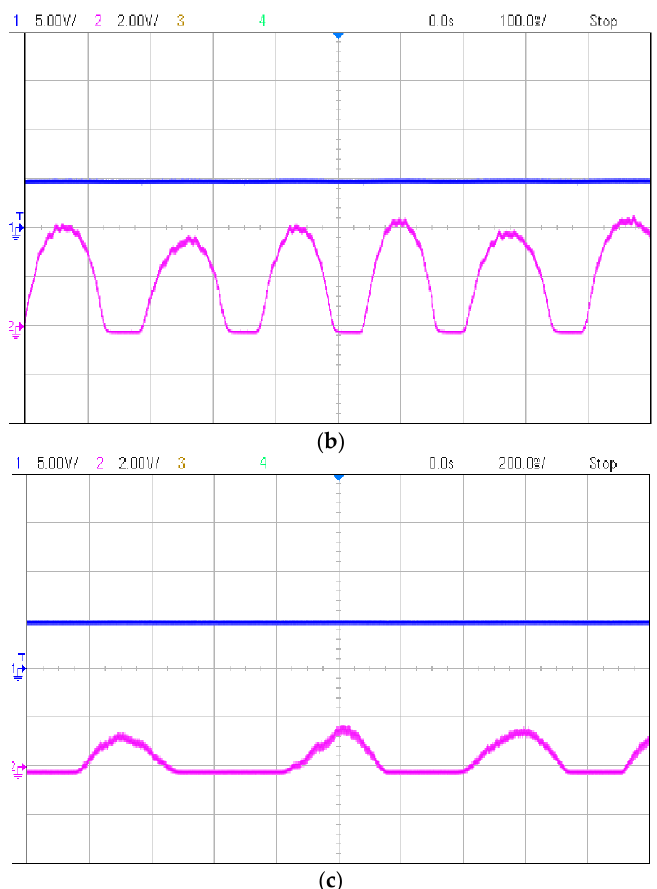
Figure 21. Supercapacitor voltage (blue) and current (purple) waveforms in speed ( a ) 1 m/s and ( b ) 0.5 m/s ( c ). ( b ) 0.5 m/s ( c